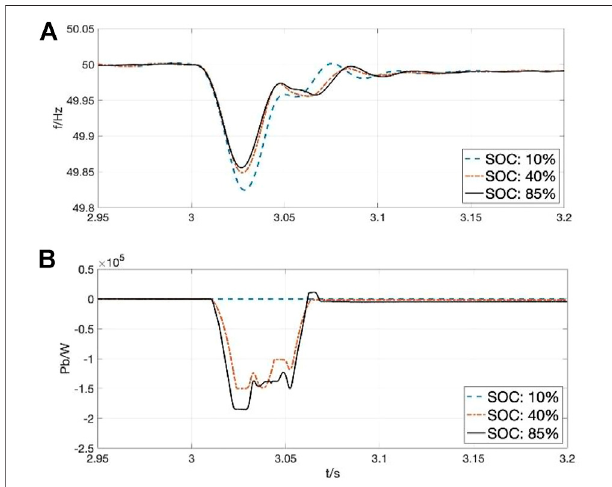
FIGURE10| Resultsforcase4. (A) systemfrequency. (B) outputpower of the BESS.